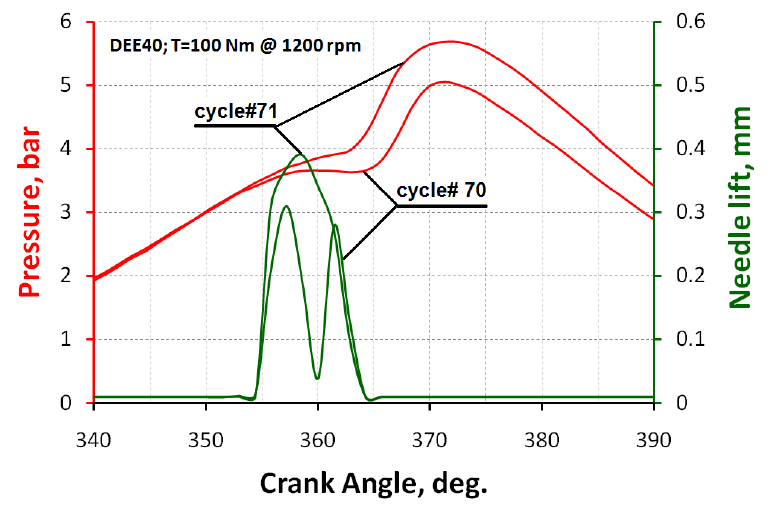
Figure 9. Variation of the in-cylinder pressure and the fuel injector needle lift vs. CA recorded at cycle no. 70 and 71 of the engine work.